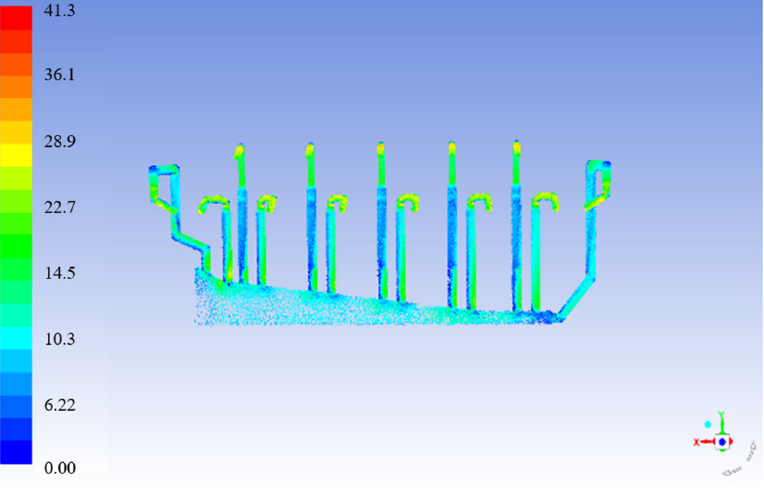
Figure 8. Velocity vector diagram of secondary air box and each branch pipe.